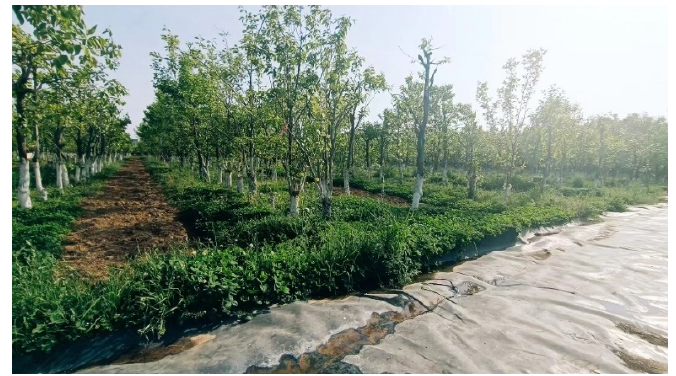
Figure 16. Orchard traction spraying robot test site.